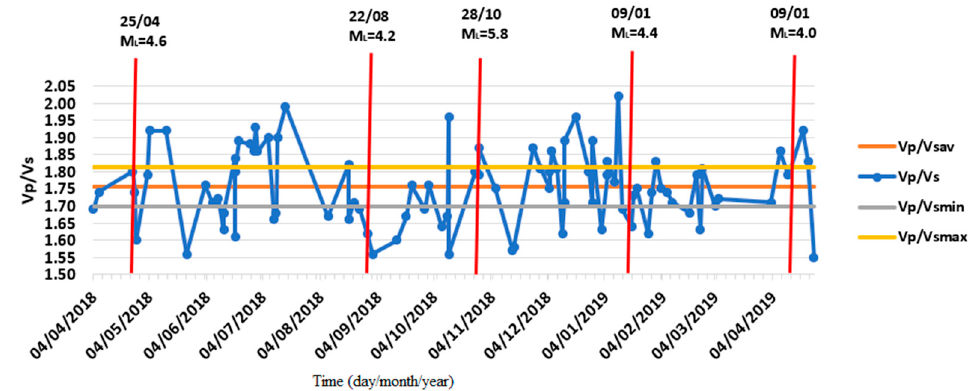
Figure 9. Vp/Vs temporal variation as determined by analysis of earthquakes that occurred in the Vrancea and surrounding areas during the specified time period (1 April 2018–30 April 2019) within a depth interval of 120 to 150 km. Significant earthquakes produced during the specified period are marked with red vertical lines.